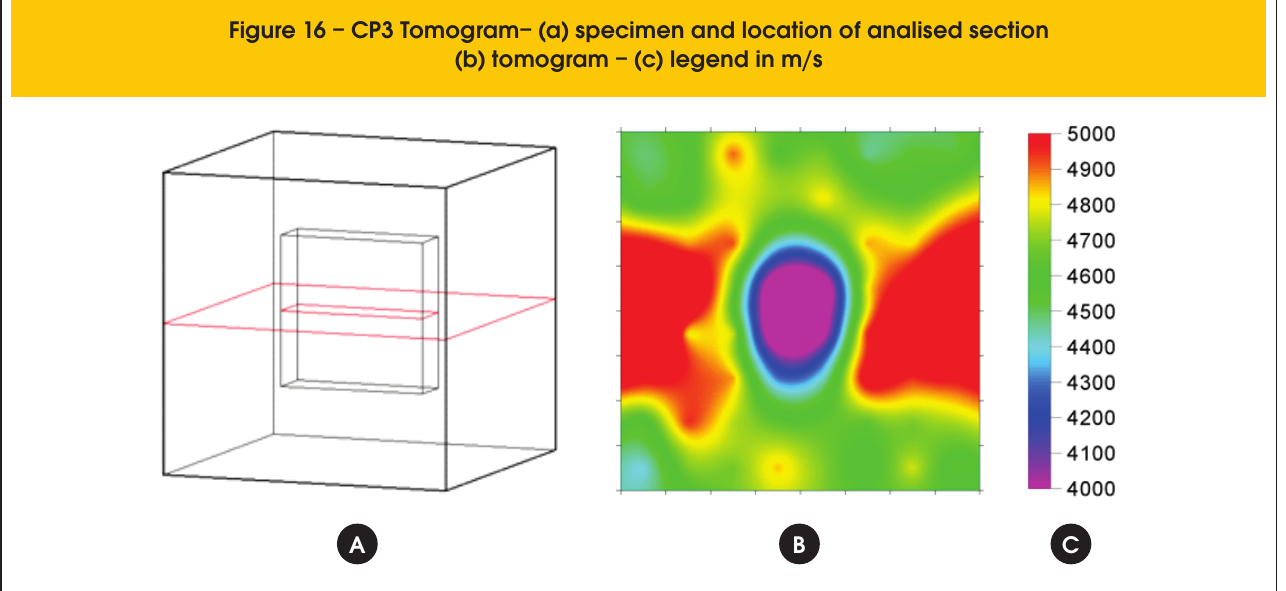
Figure 16 – CP3 Tomogram– (a) specimen and location of analised section